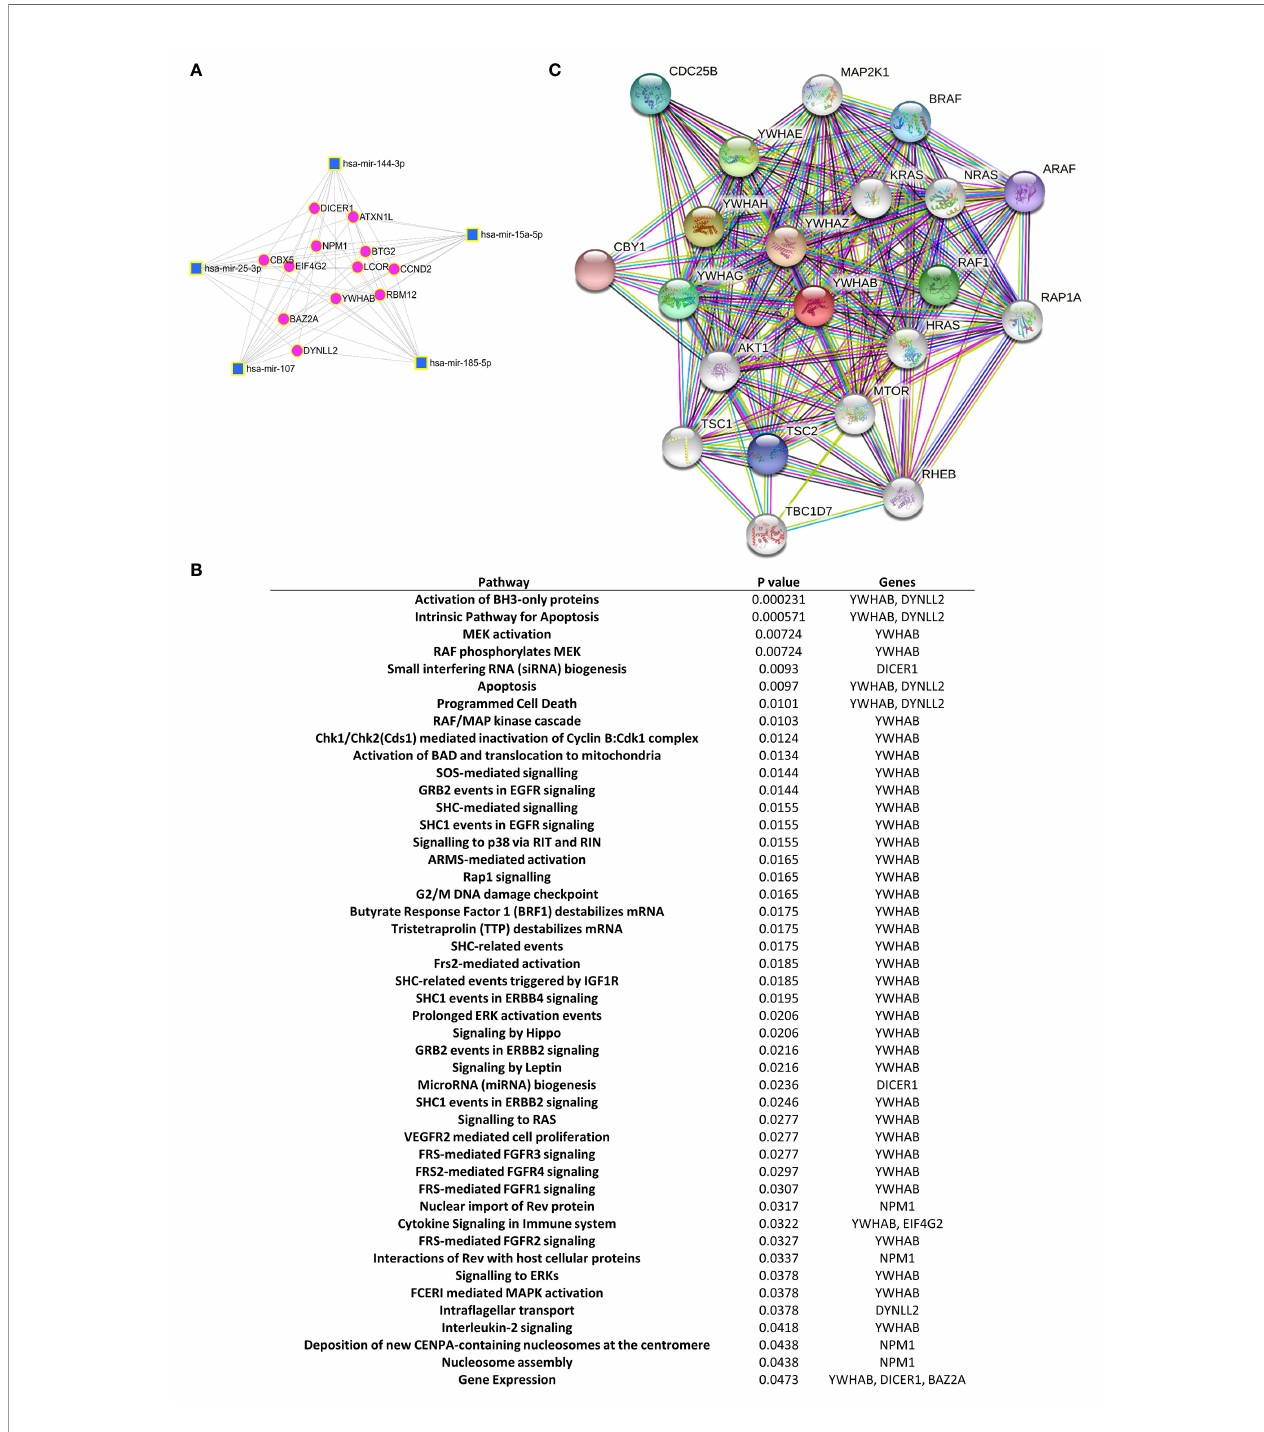
FIGURE 3 | Gene and protein pathway regulatory networks of the selected exomiRNA-targets. (A) Network miRNet analysis shows the major set of signi fi cantly dysregulated exomiRNAs in the early RA group and their shared target genes. Cluster hubs: squares indicate exomiRNAs and circles indicate their target genes. (B) Reactome pathway analysis displays the signi fi cant pathways connecting the target genes of the dysregulated exomiRNAs in patients with early RA. (C) STRING analysis of protein-protein interaction network of YWHAB protein. Colored circle predicted functional partners of YWHAB. White circle means proteins that are regulated by the interaction of YWHAB with its functional partners. Different colors lines represent different evidence of connection between proteins (Dark green - neighborhood, red - gene fusion, blue - co-occurrence, black - co-expression, pink - experimental evidence, turquoise - database evidence, light green - evidence from text, violet - homology between the two